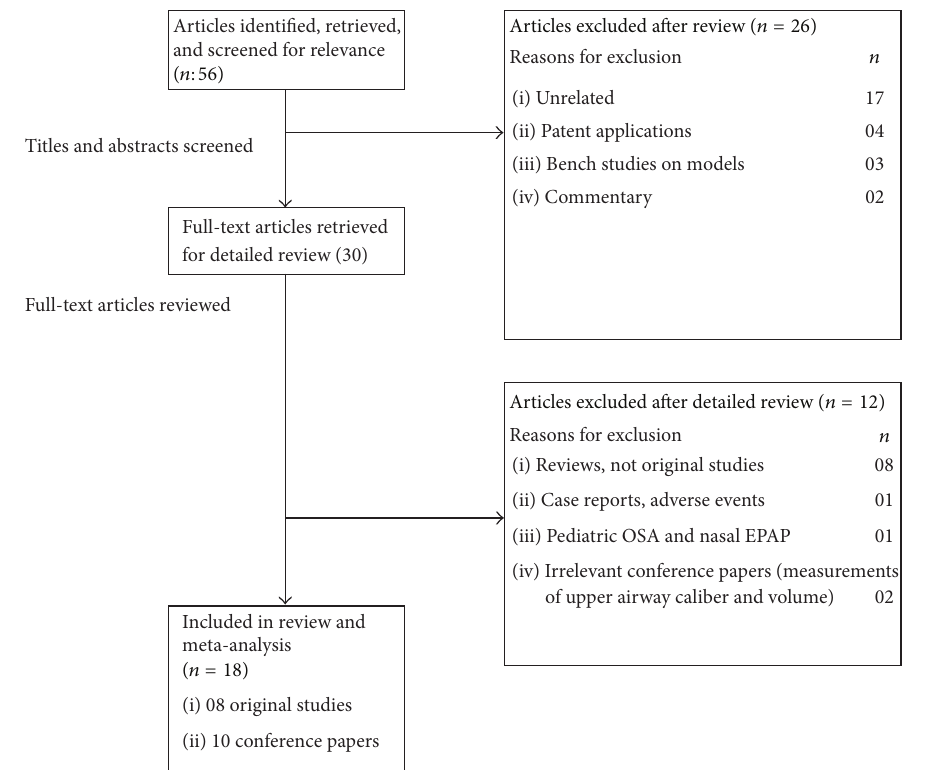
Figure 1: Nasal EPAP devices study selection